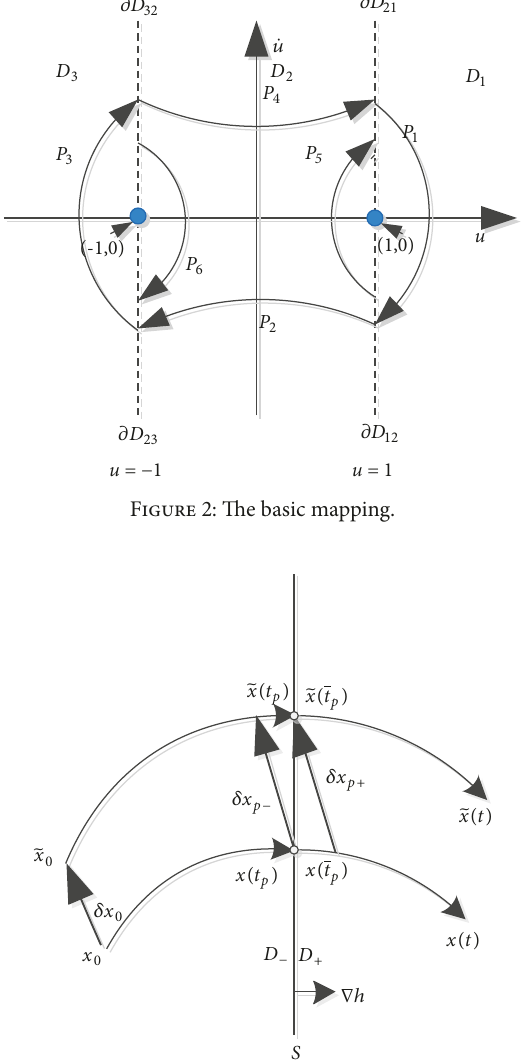
Figure 3: The noncritical discontinuous mapping. interface to the subspace 𝐷 + . Make the trajectory 𝛿𝑥 𝑝+ in front of 𝑡 𝑝 the first-order Taylor